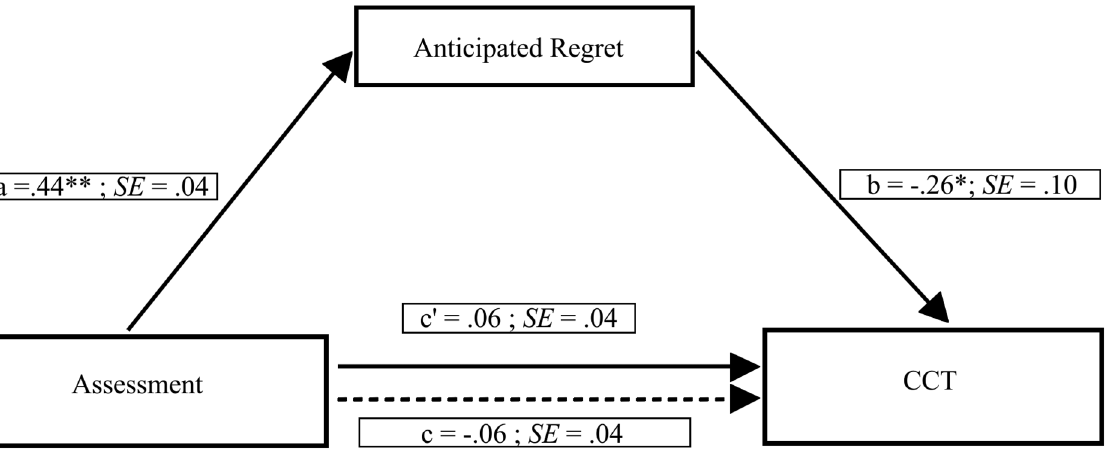
Fig 4. Mediation model showing the effect of the assessment orientation on risk-taking through anticipated regret. Path values represent standardized regression coefficients. The (c') value represents the effect, from bootstrapping analyses, of the assessment orientation on risk-taking after the mediator is included. Dotted line (c) represents the effect of the assessment orientation on risk-taking prior to the inclusion of anticipated regret. * p < .05; ** p <